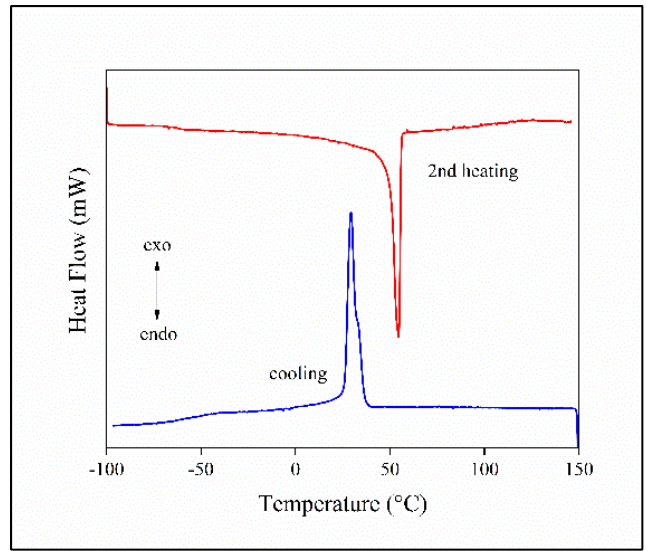
Figure 4. DSC melting and crystallization curves recorded on a PCL/halloysite composite prepared by film casting at 5 vol% halloysite content.